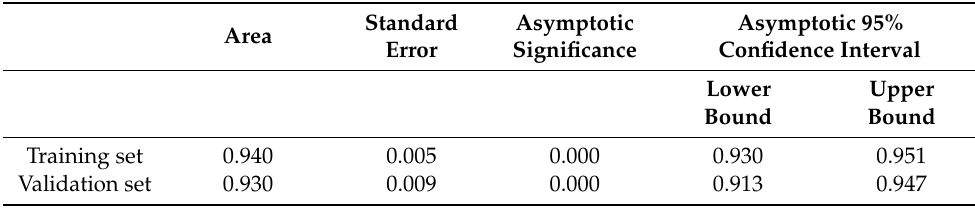
Table 8. Results of the area under ROC curve (AUC) analysis.